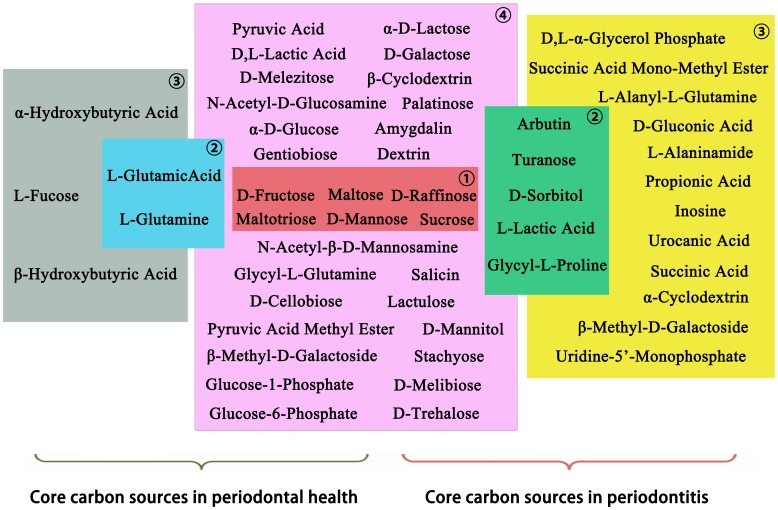
Core positive carbon sources in the healthy subjects and periodontitis patients.Inner box (numbered with 1), positive carbon sources found in all subjects (100%); middle boxes (numbered with 2), present in 71–99% of subjects from each group (H: healthy, P: periodontitis); outer boxes (numbered with 3), present in 50–70% of subjects from the healthy and periodontitis groups; middle box (numbered with 4), positive carbon sources present in at least 50% of subjects in both the healthy and periodontitis groups.